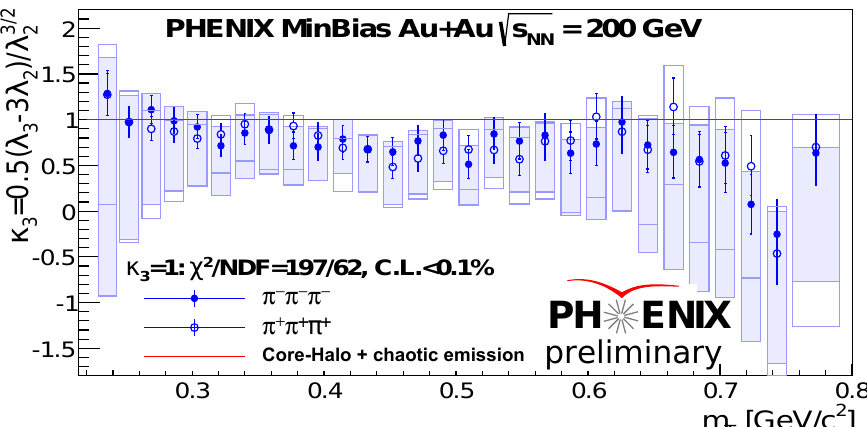
Figure 3. Core–halo independent parameter as a function of m T . Statistical and preliminary systematic uncertainties are shown as bars and boxes, respectively.